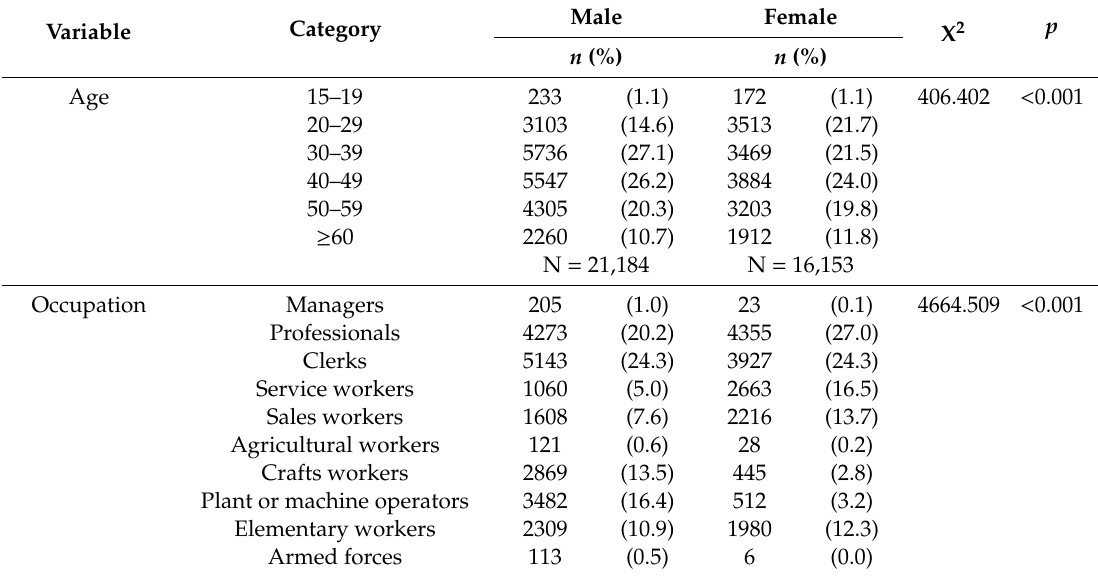
Table 1. Comparison of occupational characteristics by